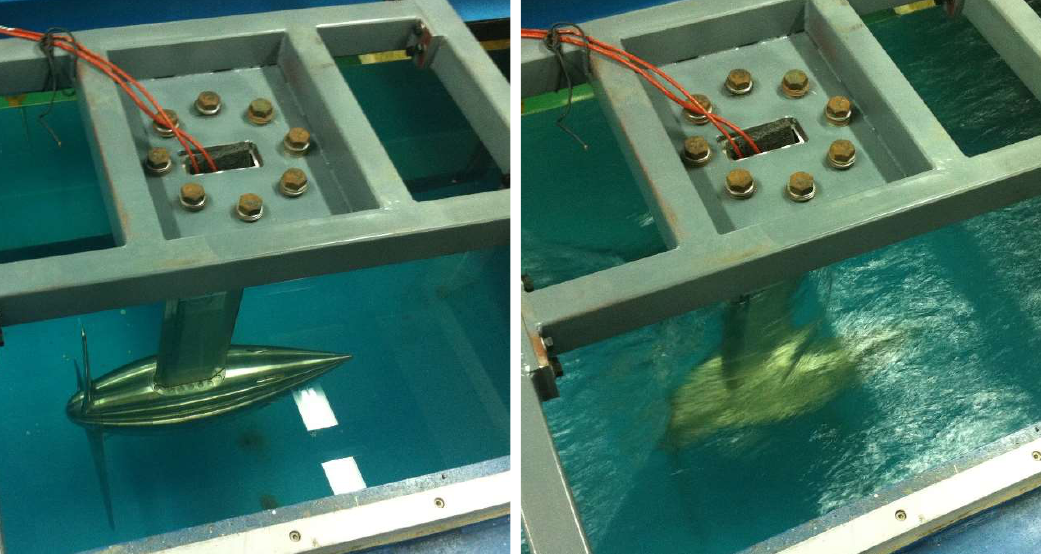
Figure 9. Permanent magnet synchronous generator (PMSG)-based tidal stream prototype into a water tunnel with illustration of turbulences and waves (left).